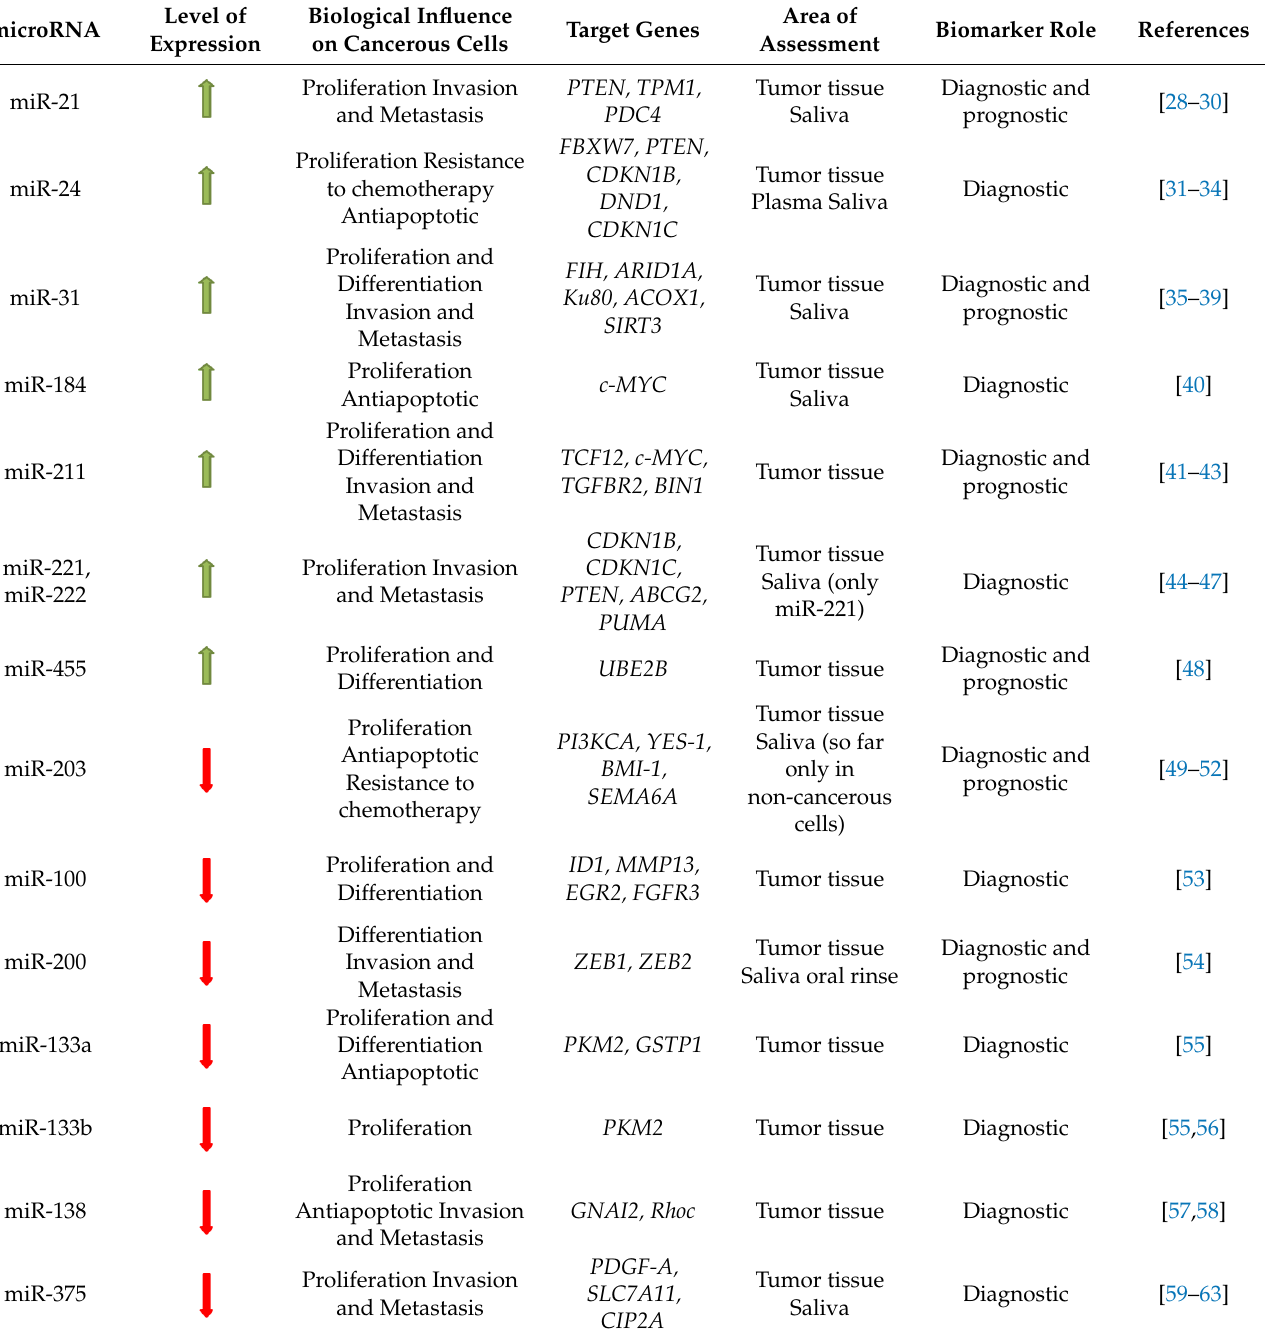
Table 1. The most important dysregulated miRNAs and their impact on oral cancer pathogenesis.